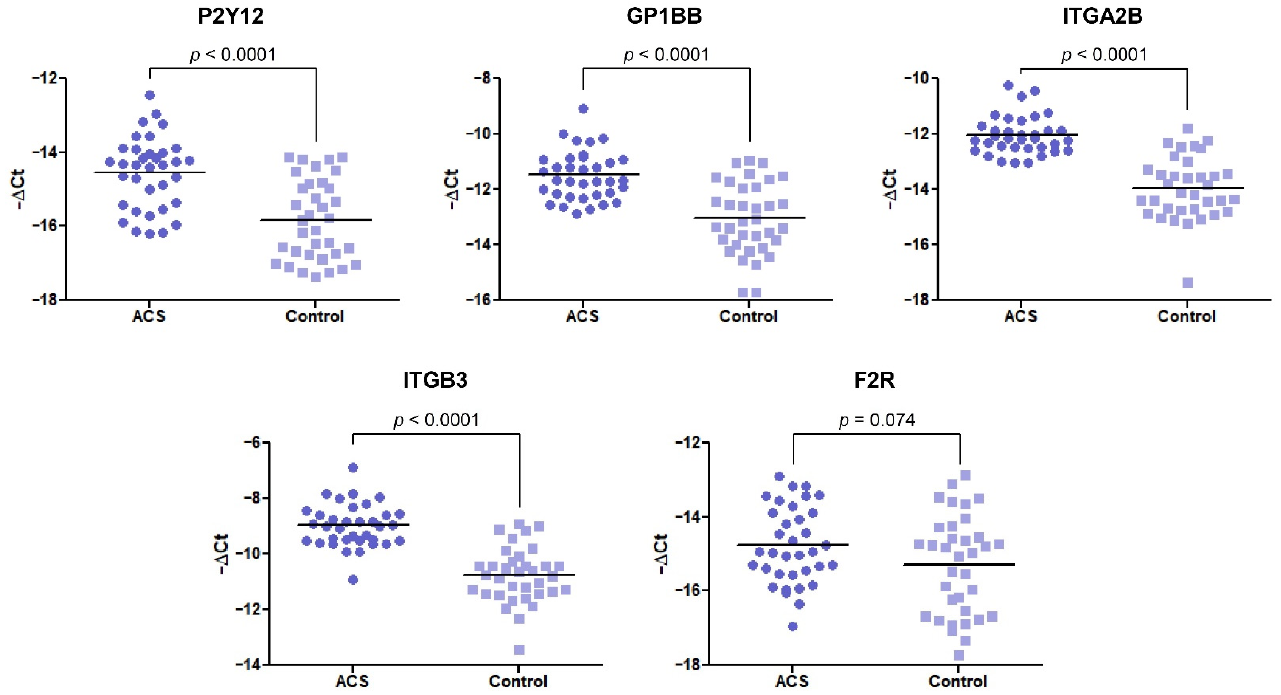
Figure 1. The mRNA expression levels of P2Y12, GP1BB, ITGA2B, ITGB3, and F2R in platelets of ACS patients compared with the control group. The relative expression of the selected genes was illustrated with −Δ Ct value. 18S rRNA was used as a reference gene. Data are plotted as individual values with horizontal bars presenting the mean. The p -values reported above the graphs represent the results of the Student’s t- test, or, in cases of unequal variance, Welch’s t- test. F2R was not statistically significant with p = 0.074.